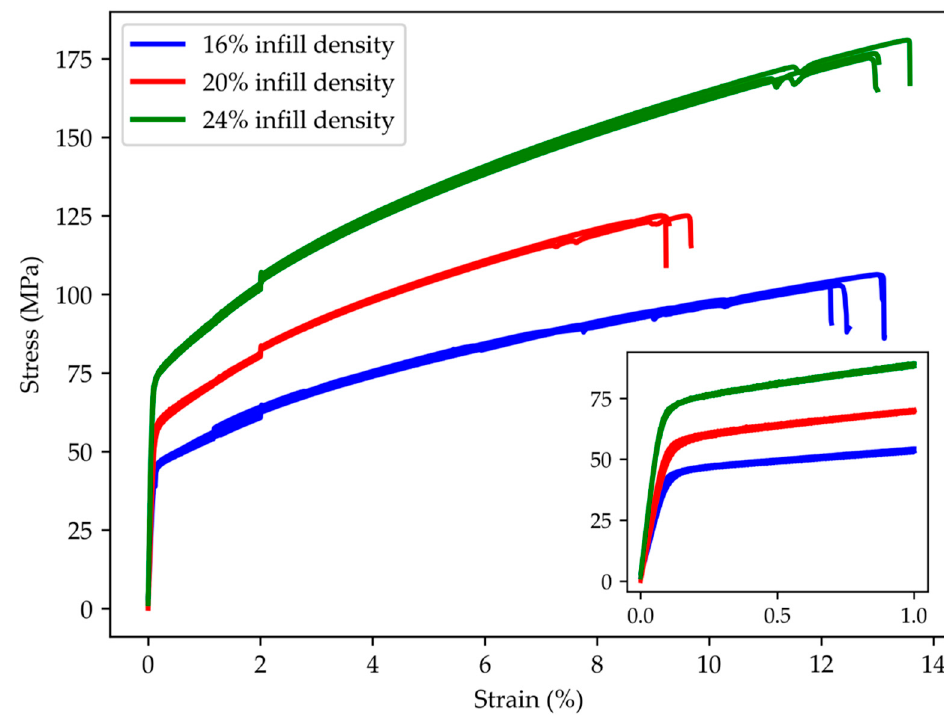
Figure 8. The stress–strain curves of 316L stainless steel infill specimens.